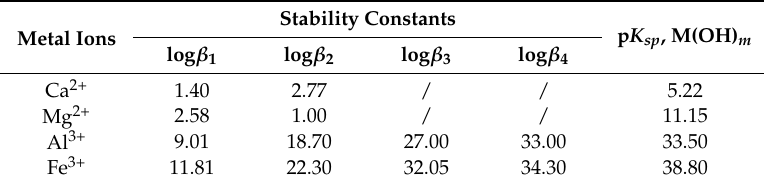
Table 1. The stability constants of the metallic ionic hydroxyl complex.